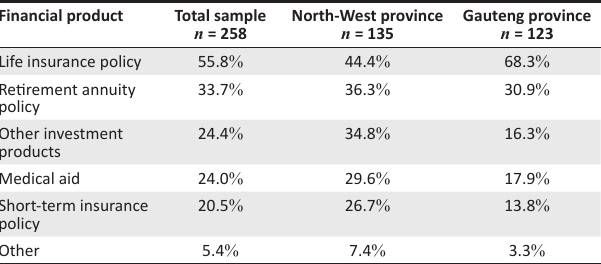
TABLE 2: Financial products bought over the last 10 years. Financial product